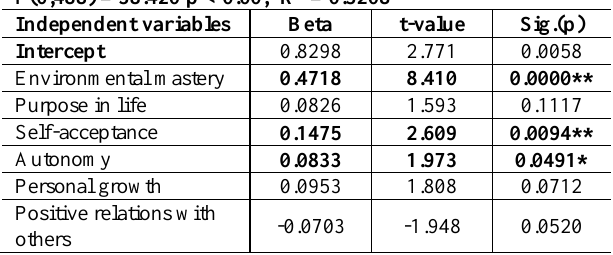
Table 6: Influence of dimensions of psychological well- being on Perceived financial